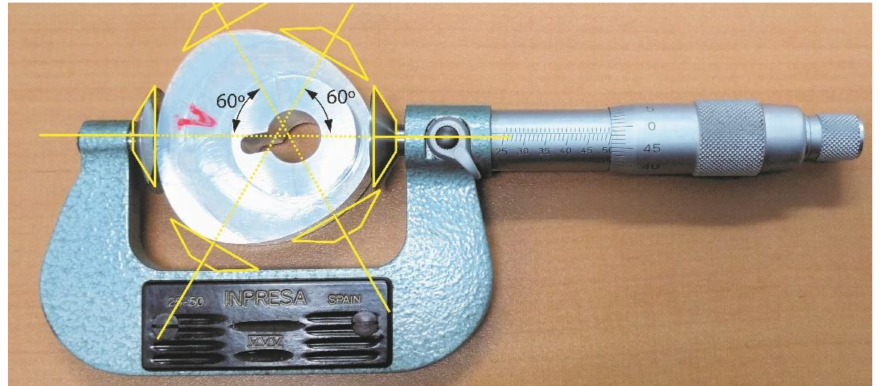
Figure 13. Dimensional measurement of the machined cams using a flange outside micrometre, and measuring